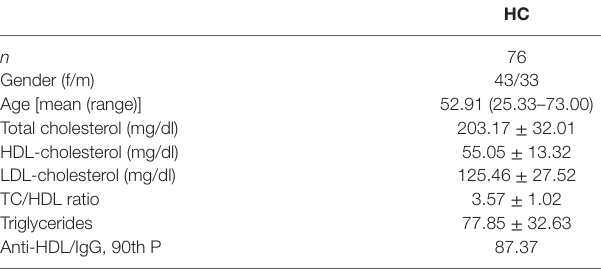
No differences in gender were observed between this HC subgroup and ANCA- associated vasculitis (p = 0.285), DMI1 (p = 0.445), celiac disease (CD) (p = 0.437), inflammatory bowel disease (IBD) (p = 0.810), and IBD/UC patients (p = 0.745). This group was comparable in terms of lipid profile and anti-high-density lipoprotein (HDL) levels to the whole HC population ( Table 1 ). Continuous variables are summarized as mean ± SD, unless otherwise stated. Categorical variables are summarized as n.